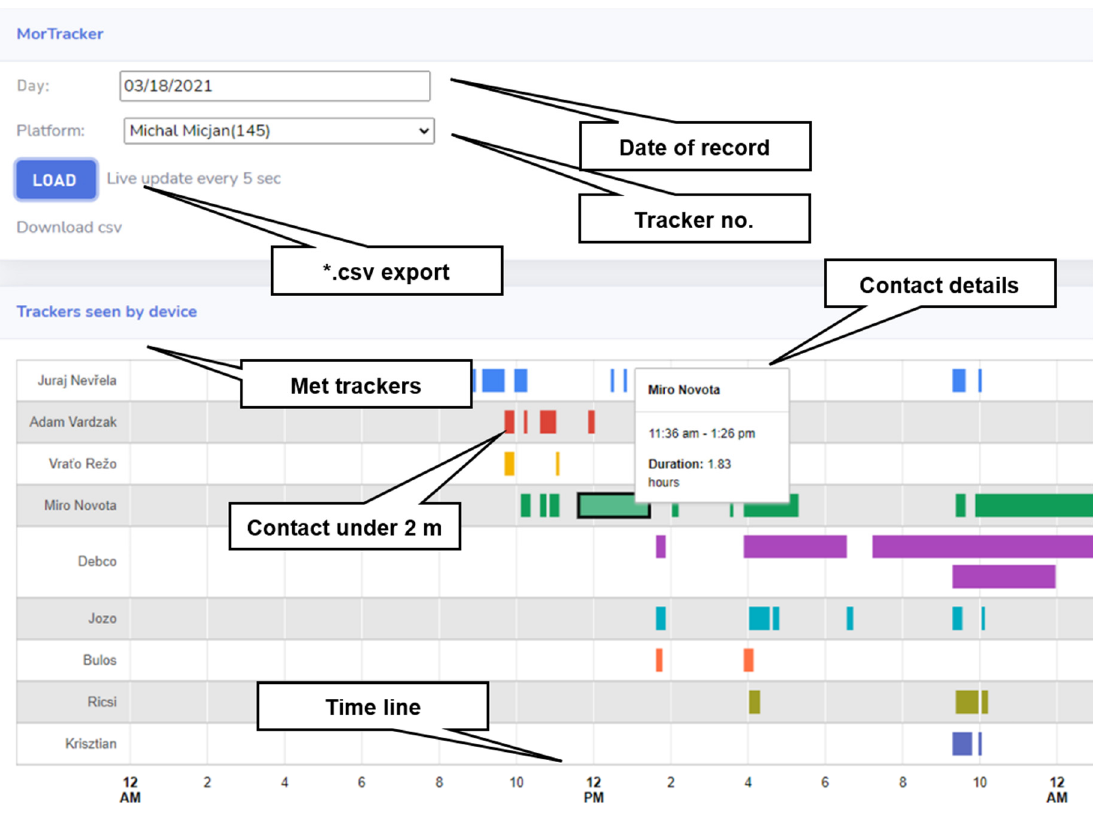
Figure 8. Functional testing—temporary user interface: Relevant (under 2 m) contacts of tracker no. 145 (Michal Micjan) on 18 March 2021 are displayed. Highlighted 1.83-h meeting with Miro Novota at 11:36 a.m.